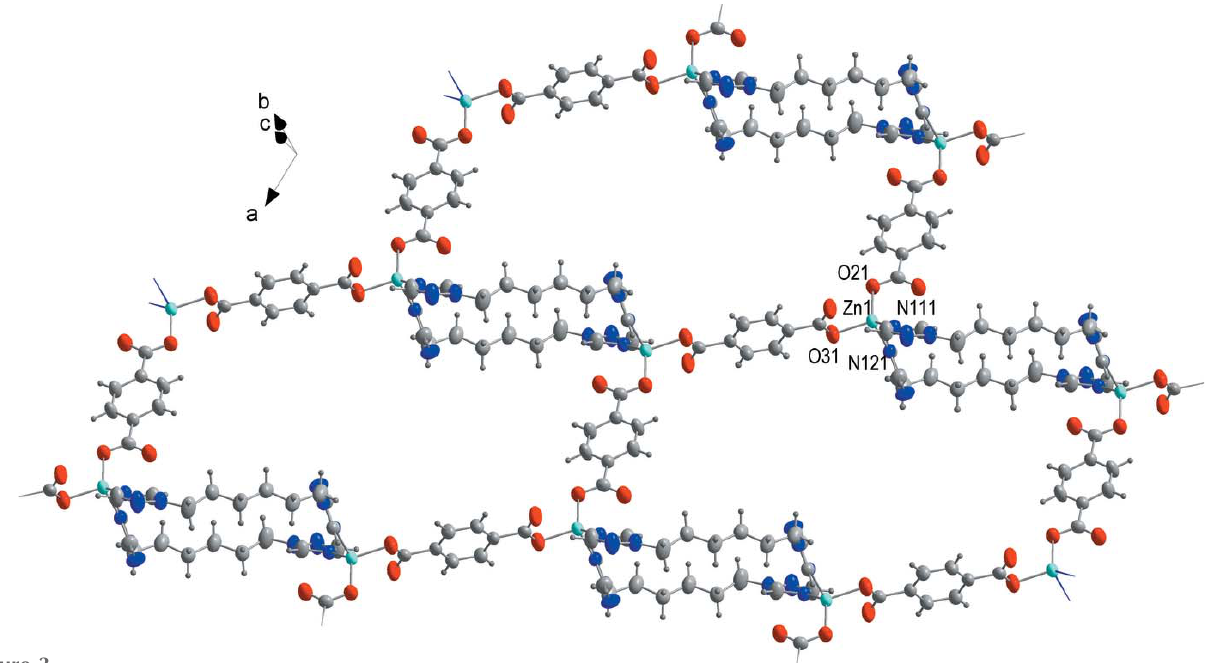
Figure 3 Displacement ellipsoid plot of a single layer of the coordination polymer showing ellispoids drawn at the 50% probability level.